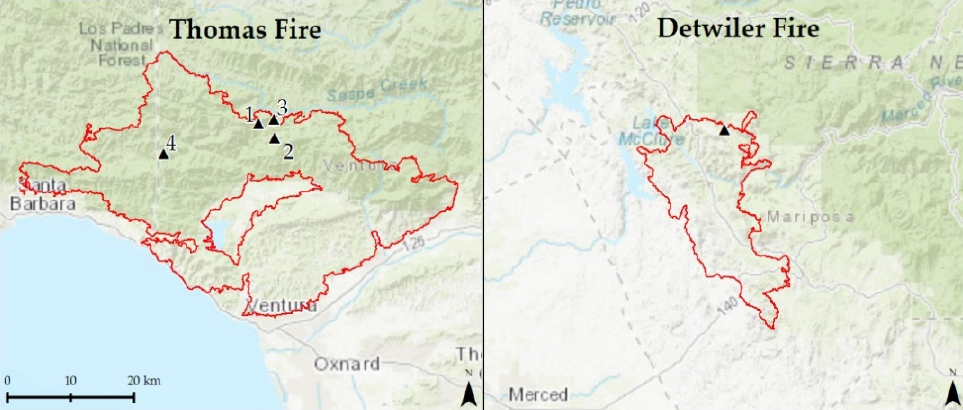
Figure 1. Two study wildfires in California. Map shows general burn externs of 2017 Detwiler and Thomas Fires. Numbers depict locations of airborne thermal infrared imaging sequences within burn extents (see Table 1).